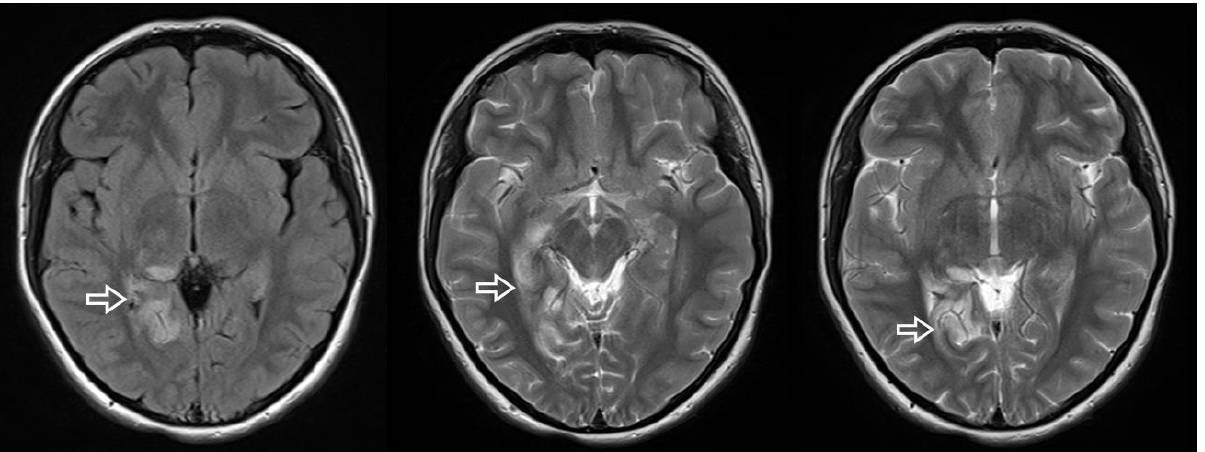
Figure 1. Brain MRI axial sections showing the ischemic lesions in the territory of the right posterior cerebral artery (arrow).